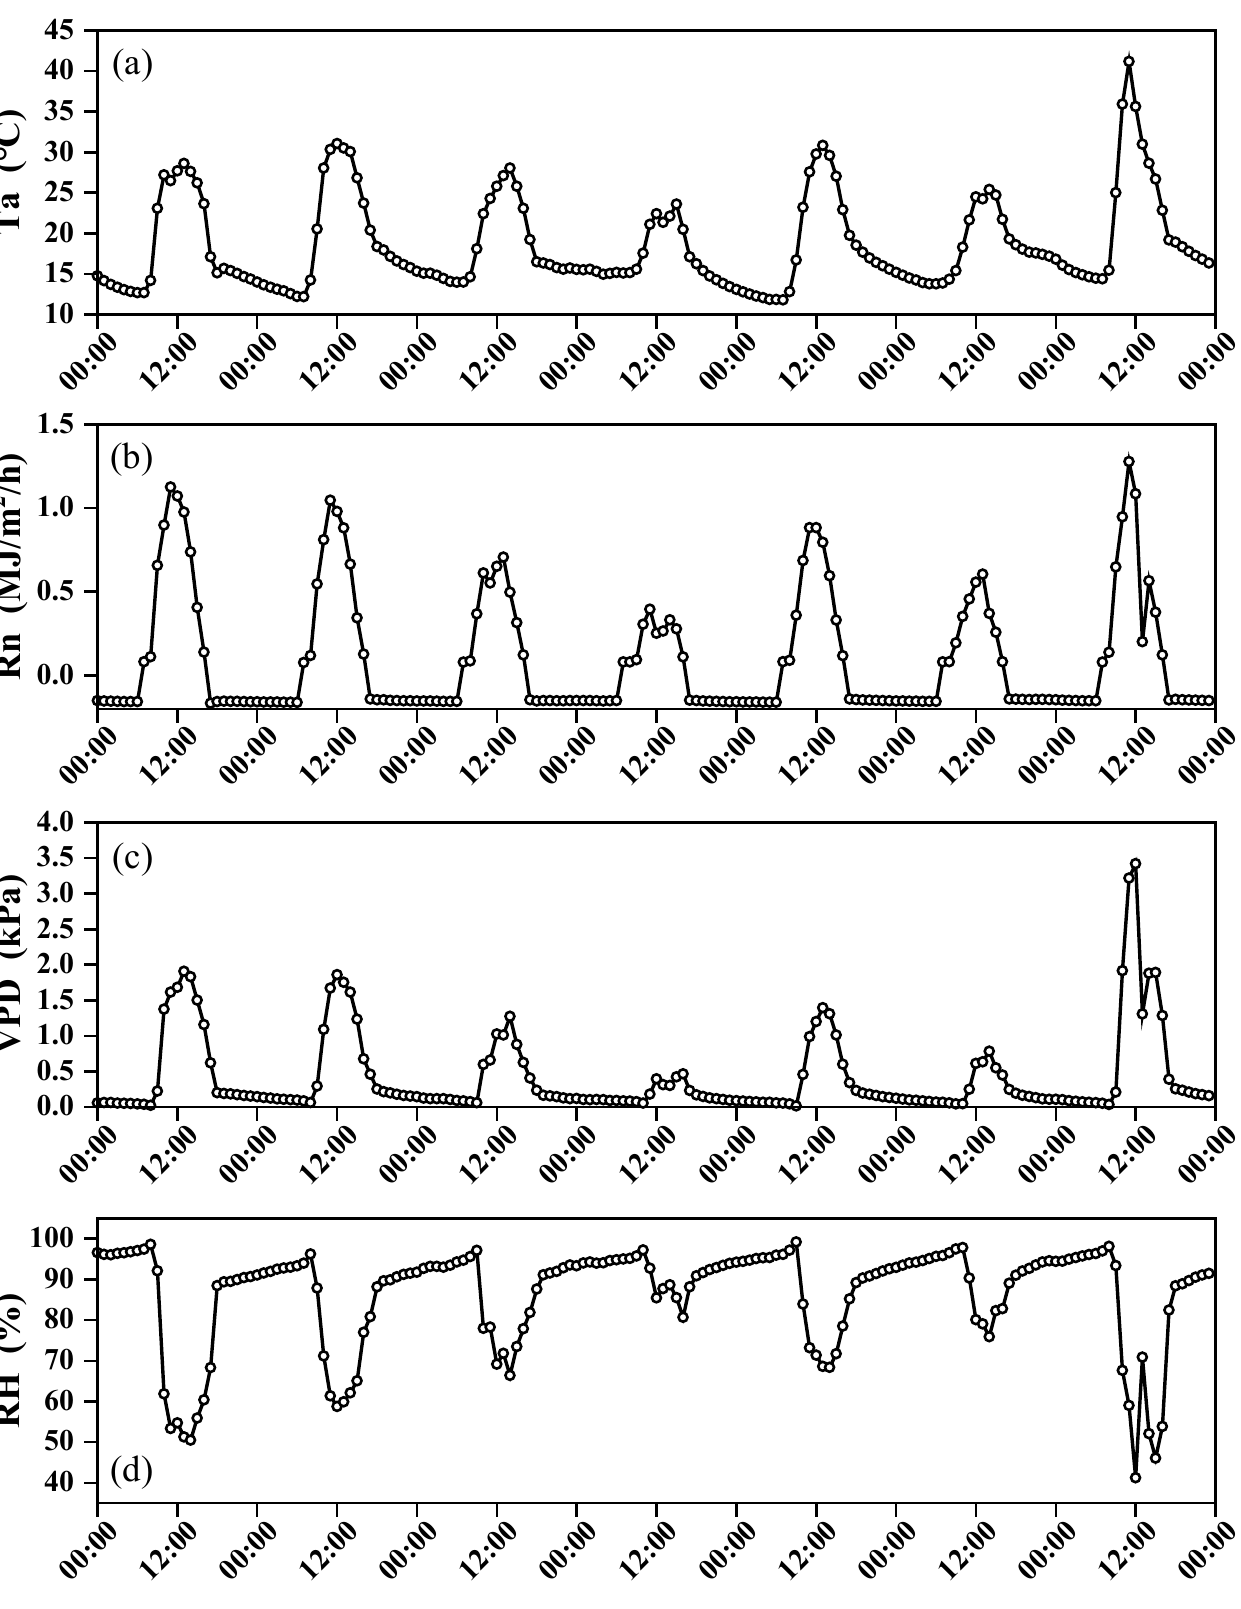
Figure 7. Daily courses of hourly air temperature ( a ), net radiation ( b ), vapor pressure deficit ( c ), and relative humidity ( d ) in the sunken solar greenhouse from 4 to 10 November in the 2019 season.